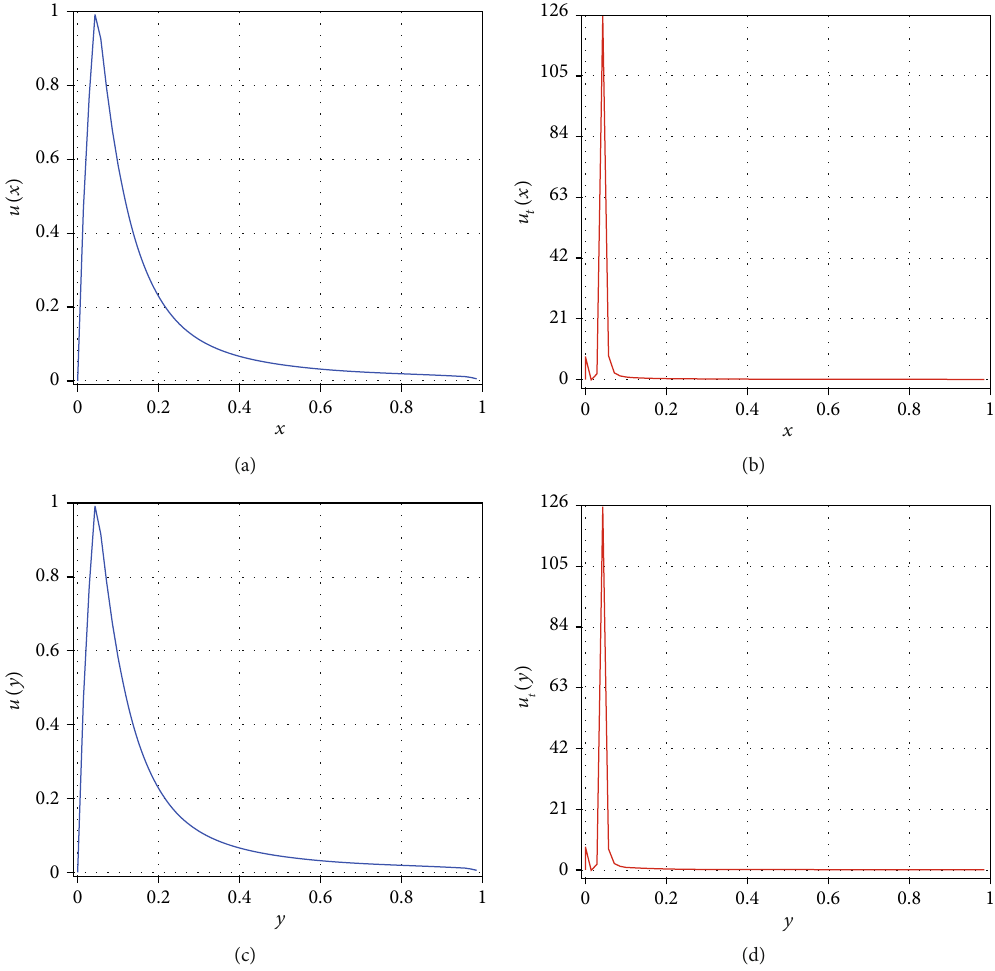
x increases, (c) u as y increases, and (d) u t as